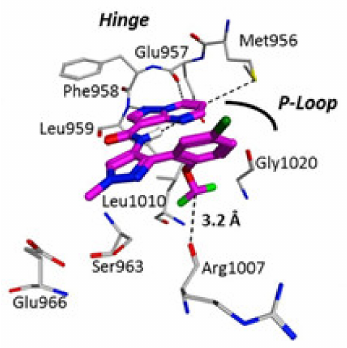
Figure 51. X-ray crystal structures of compound 43 in complex with JAK1